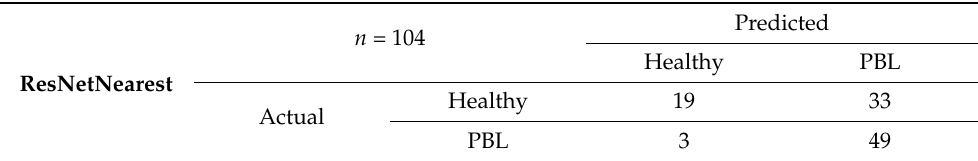
Table 4. Confusion matrix results for each ResNet